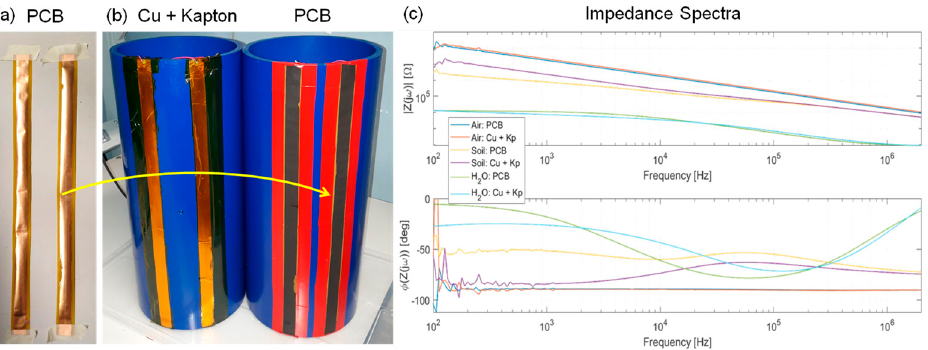
Figure 10. Comparison of the copper electrodes fabrication approaches manual vs. industrial flexible PCB manufacturing: the measured impedance spectra overlaps in all conditions (air, water and soil) demonstrating their equivalence.